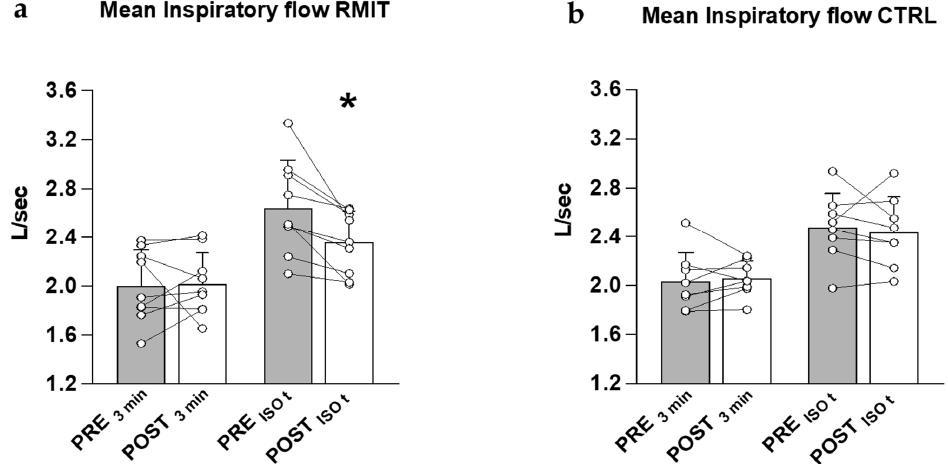
Figure 4. ( a , b ). Mean ( ± SD) and individual values of V T /T I at the third minute and ISO-time of CWR>GET, for RMIT and CTRL. * significant difference vs. PRE ( p =